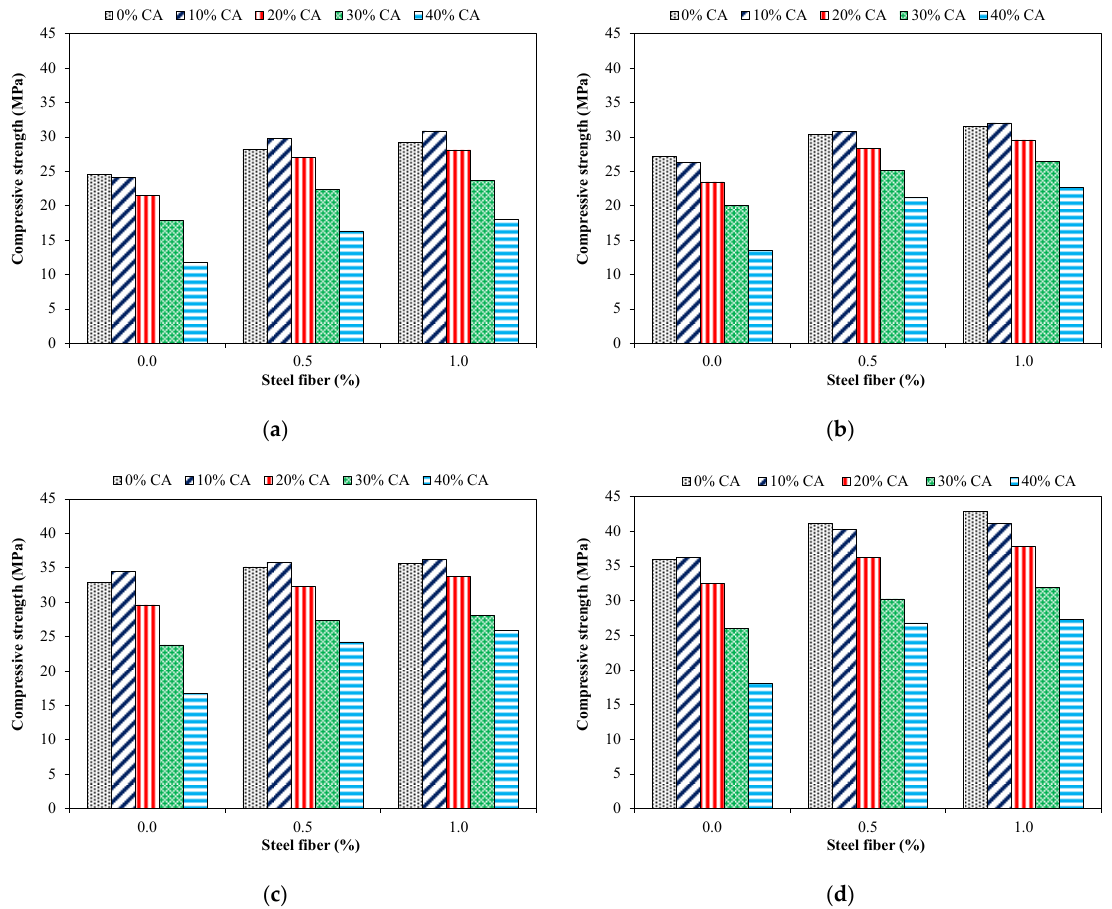
Figure 7. Compressive strength for specimens with various steel fibers and CA dosages cured in normal water: ( a ) 14 days; ( b ) 28 days; ( c ) 56 days; ( d ) 90 days.